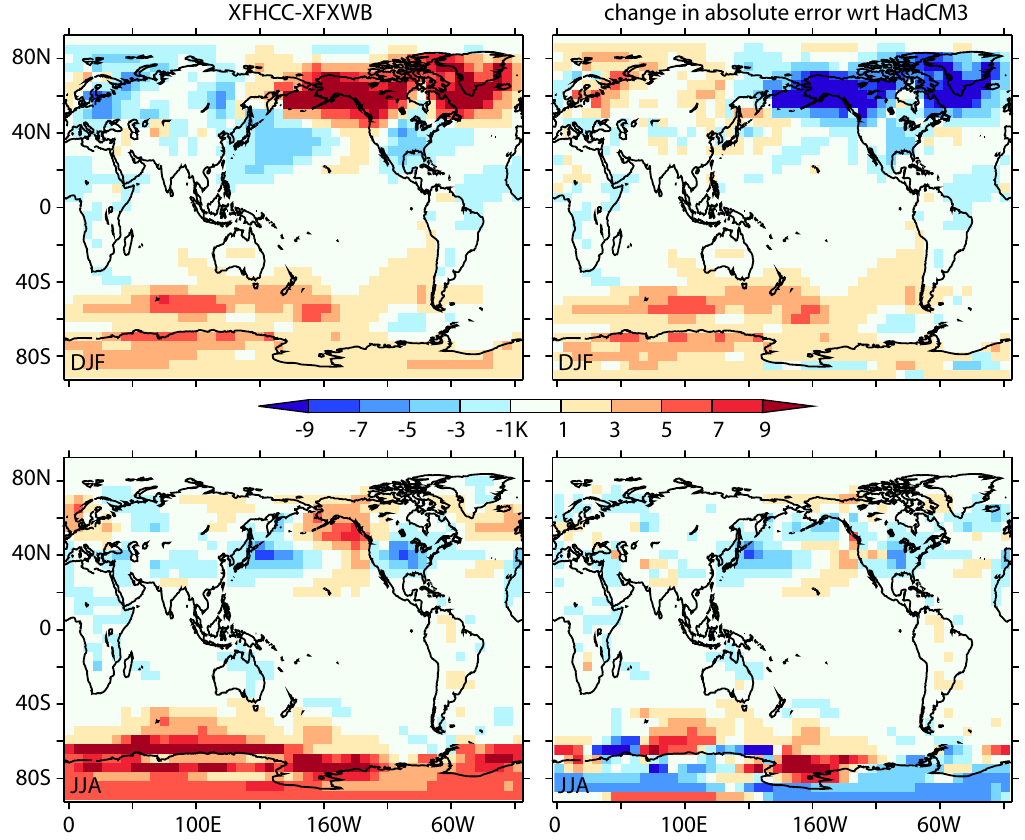
Fig. 5. Difference in seasonal surface temperature. Left: XFHCC-XFXWB; right: change in magnitude of error with respect to HadCM3; top: DJF; below: JJA.